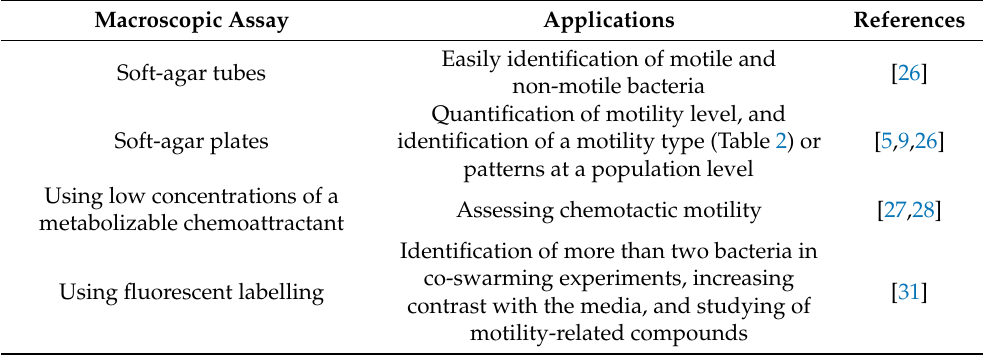
Table 1. Macroscopic assays to study bacterial motility.